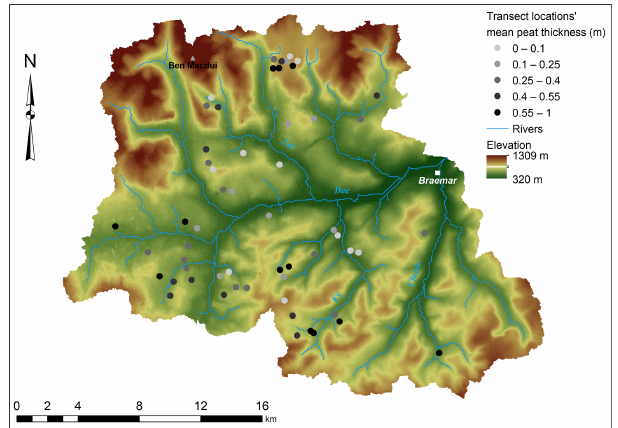
Figure 4. Mean measured peat thickness at the hillslope transects ( n =